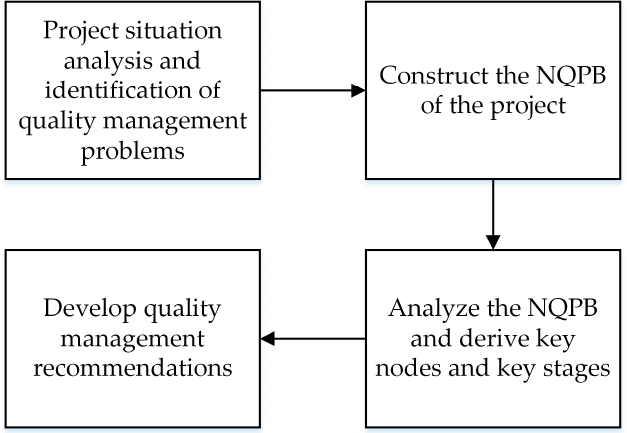
Figure 8. Process of the quality management analysis using the NQPB method.